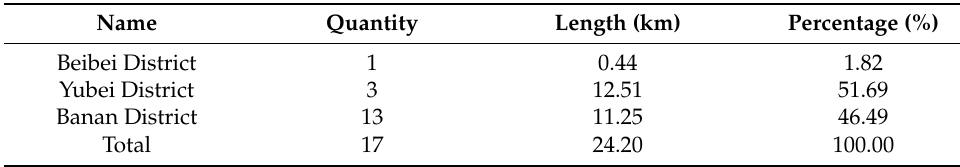
Table 9. Length statistics of ecological barrier points.